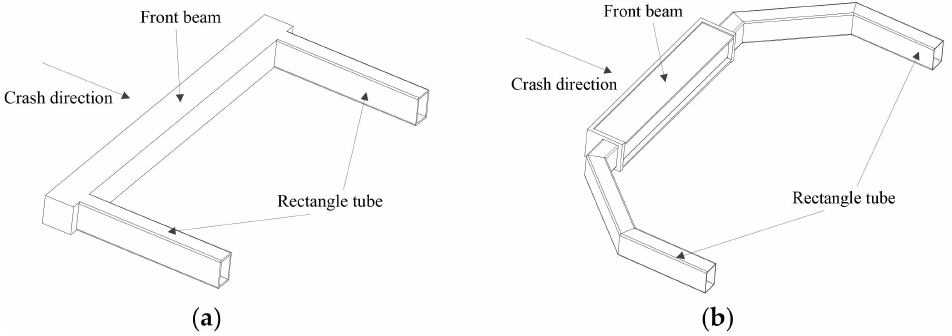
Figure 1. Frame energy-absorbing structure. ( a ) Normal style, ( b ) five-section tubular C-shaped